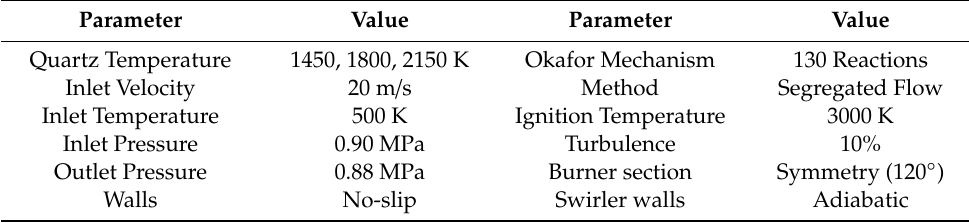
Table 2. Boundary conditions; high-pressure, high inlet temperature conditions.